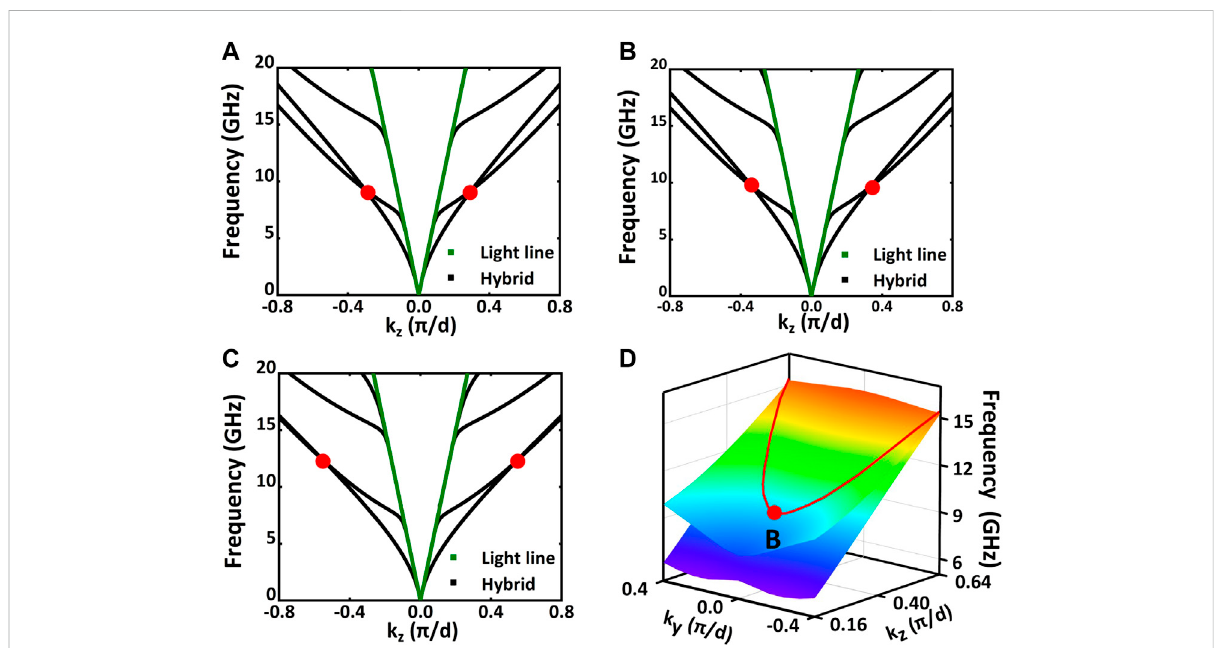
FIGURE 4 Type-IIDiraclineinthedispersiondiagramofthepositivelyuniaxialcrystalslabwhen ε z (cid:1) 100 ε 0 .showsthedispersionrelationwhen θ ischosen as 2 ° , 15 ° and 30 ° , where the red points label the linear cross of bands. 3D view around the (A-C) degeneracy B (red point), where all degenerated points give rise to the Type-II Dirac line in momentum space, which is (D) marked by red